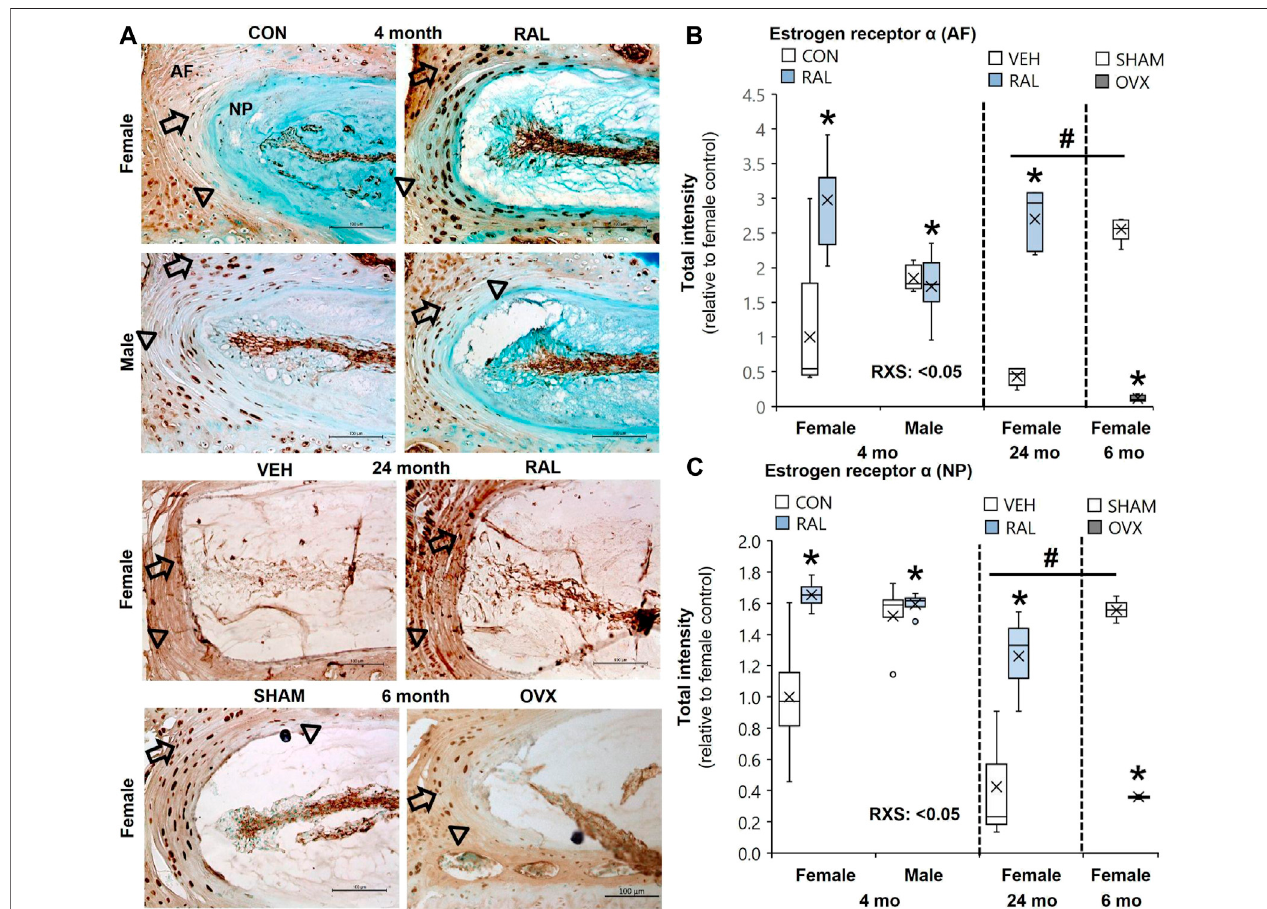
FIGURE 1 | Raloxifene increased ER- α protein expression in young and old IVDs, whereas OVX reduced ER- α protein expression. (A) Estrogen receptor- α (ER- α ) immunostaining (arrow: presence of stain, arrowhead: absence ofstain) in the (B) AF and (C) NPof young-adult (4 months), old (24 months), and OVX (6 months) mice. Data are represented as box plots with mean marked as cross (x), 25/75% deviation lines, and maximum/minimum whiskers. *: control (CON, n = 5/sex/group) vs. raloxifene(RAL);R:CONvs.RAL;S:malevs.female;RxS:interaction,vehicle(VEH, n =8/group)vs.RAL,SHAM( n =4 – 5/group)vs.ovariectomized(OVX); # :aging effect (4 months vs. 6 months vs. 24 months), p < 0.05. AF, annulus fi brosus; NP, nucleus pulposus. Scale: 100 μ